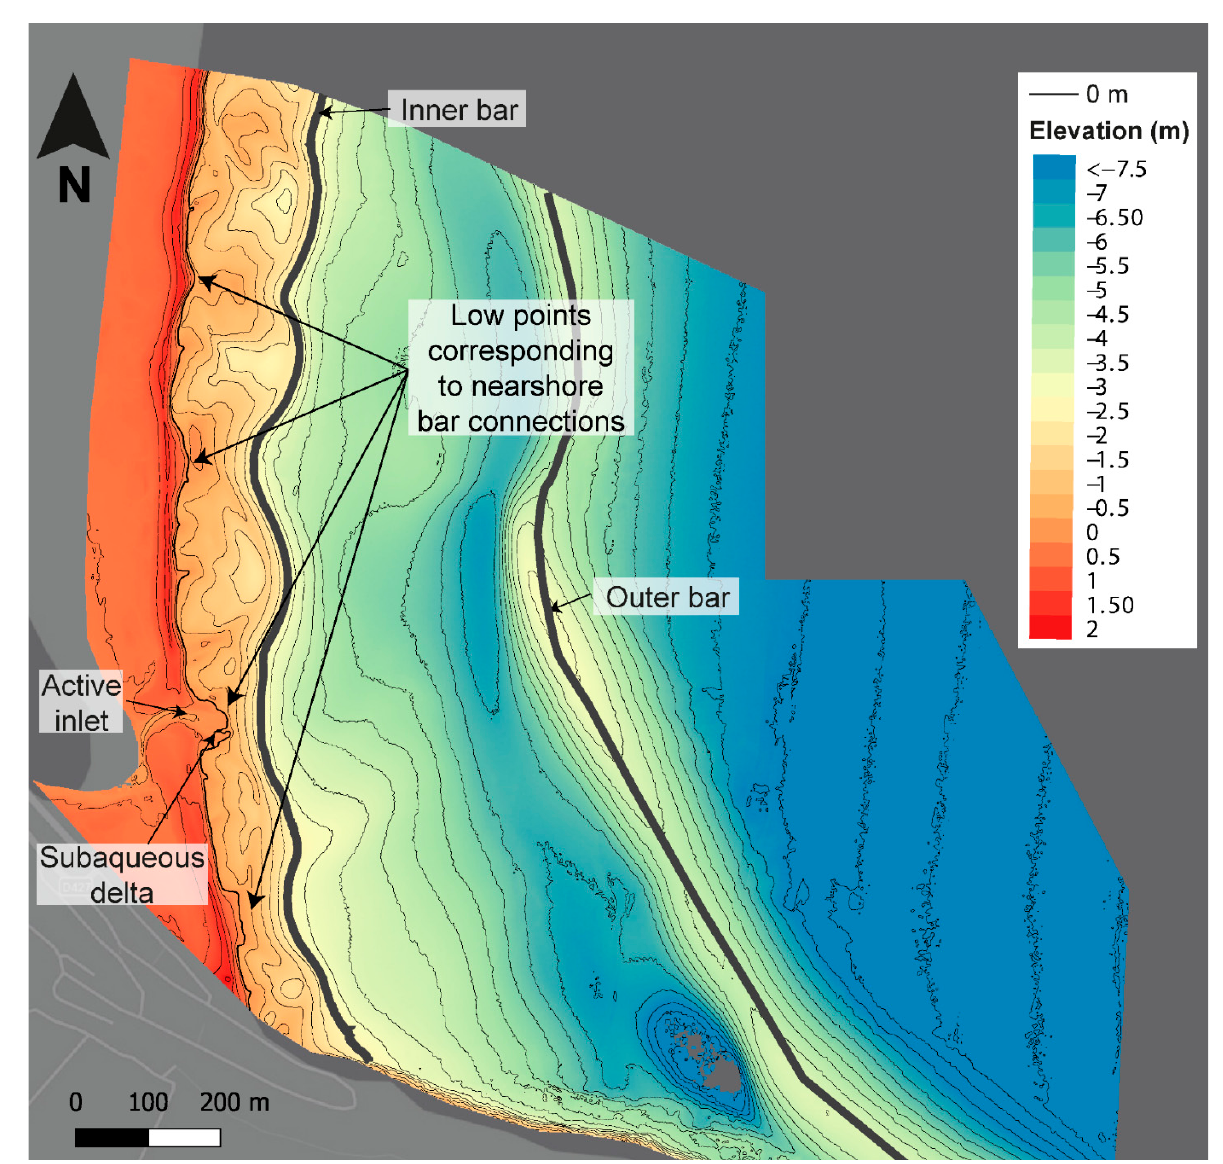
Figure 6. Morphological evolution of La Franqui beach, during periods of offshore wind with single ( I , a , c ) or multiple ( III , e , g ) inlet openings and during periods of offshore wind without inlet open ‐ ing ( II , b , d & IV , f , h ). Dotted profiles correspond to the initial profile and solid profiles to the final situation.